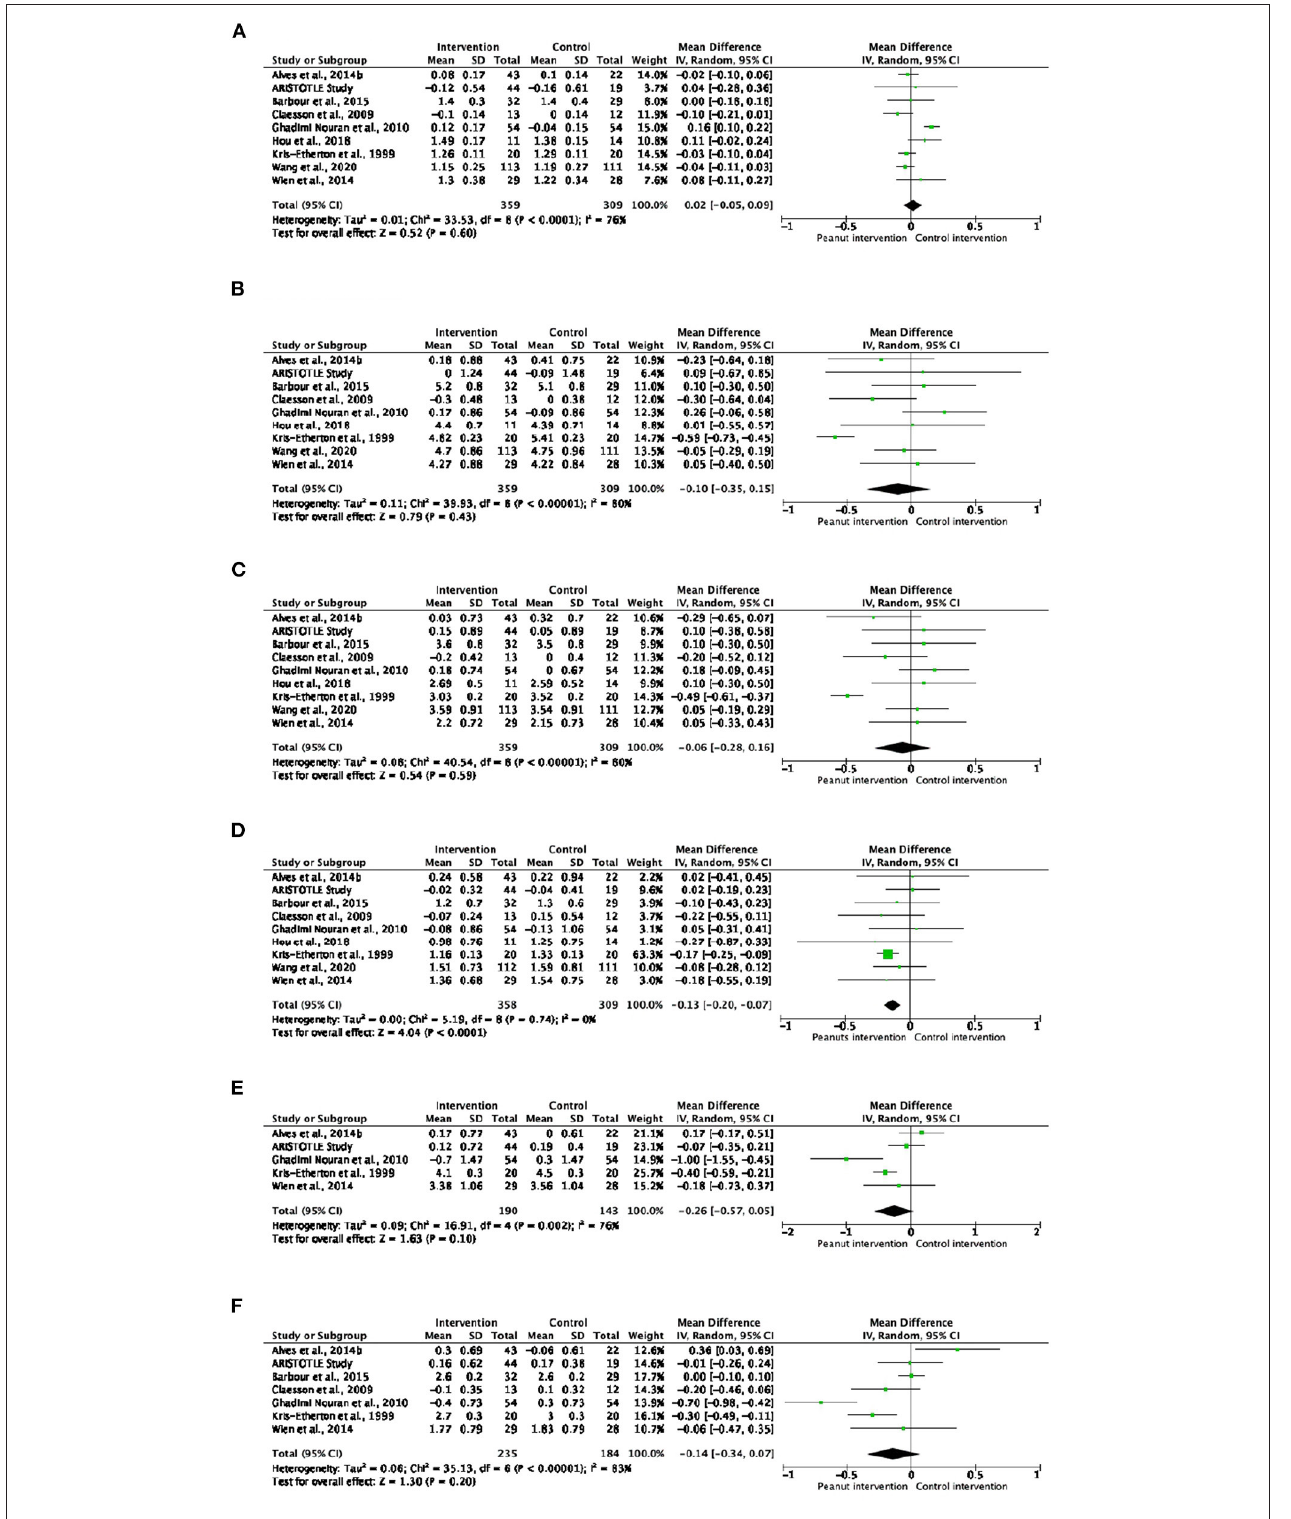
FIGURE 3 | Forest plot reporting mean differences for total cholesterol (A) , HDL-cholesterol (B) , LDL-cholesterol (C) , triglycerides (D) , total cholesterol/HDL-cholesterol ratio (E) and LDL-cholesterol/HDL-cholesterol ratio (F) associated with peanut interventions compared to control interventions. HDL, high-density lipoprotein; LDL, low-density